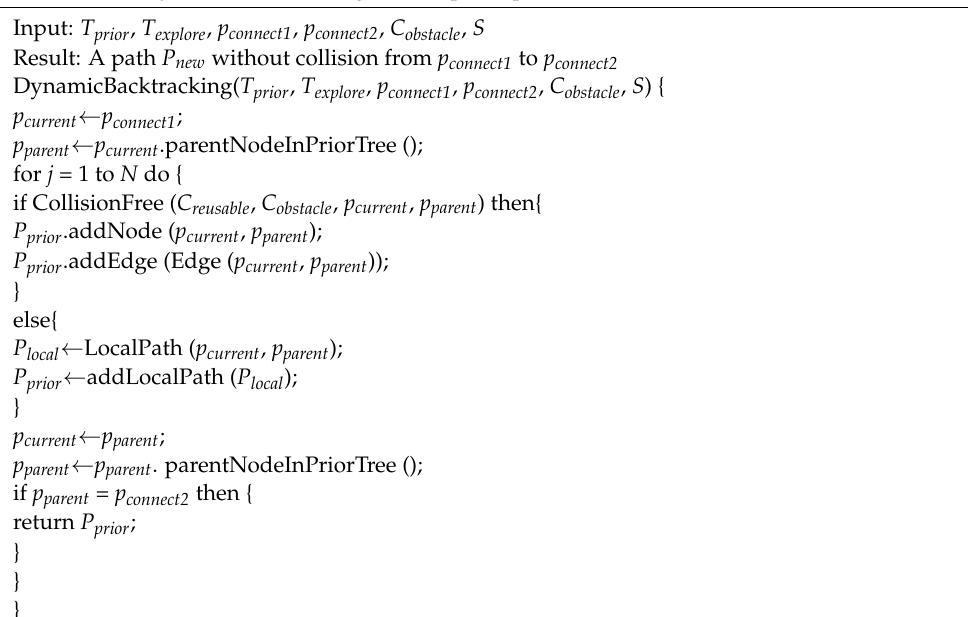
Algorithm 2 Dynamic backtracking of the a priori path.